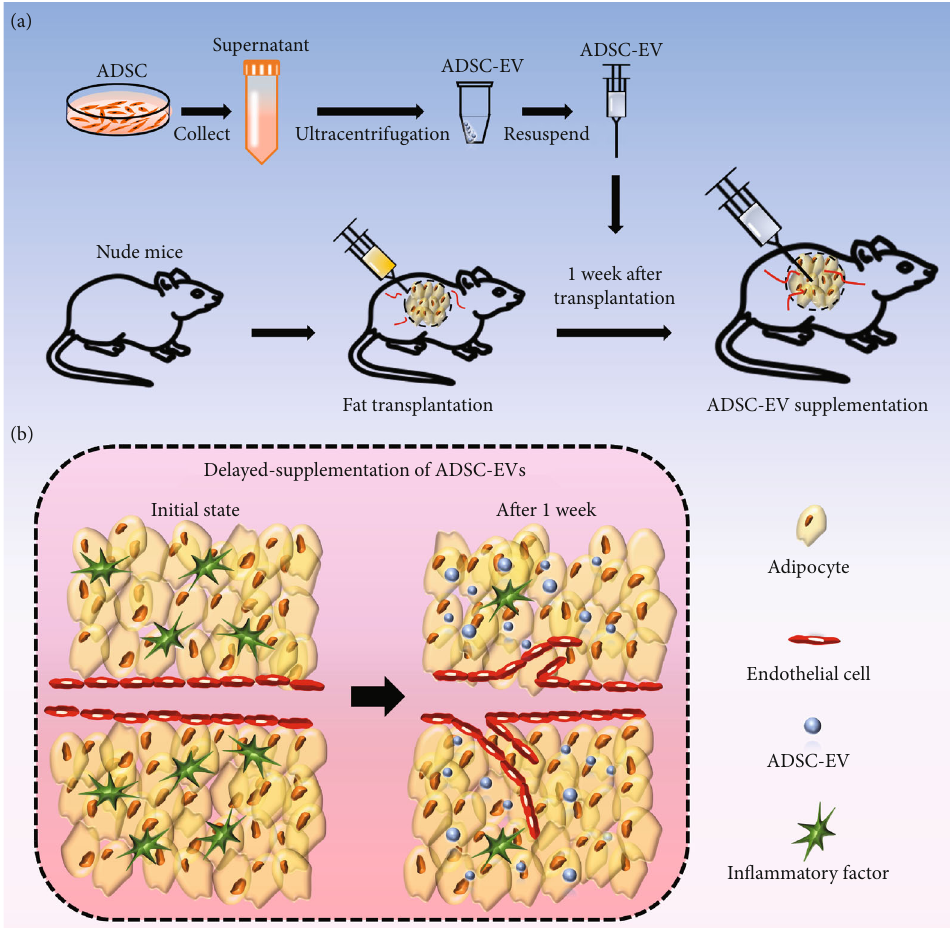
Figure 1: Schematic representation of experimental design and its potential mechanism. (a) ADSCs were cultured and the supernatant was collected. ADSC-EV was obtained by ultracentrifugation technique. Subsequently, we subcutaneously injected human fat tissue into nude mice followed by ADSC-EV injection at 1 week after fat grafting. (b) The scheme shows that, at 1-week after grafting, endothelial cells derived from the recipient are recruited to form the new vessels in transplants and the in fl ammatory reaction subsides, making the environment more conducive for ADSC-EV to display its regenerative e ff